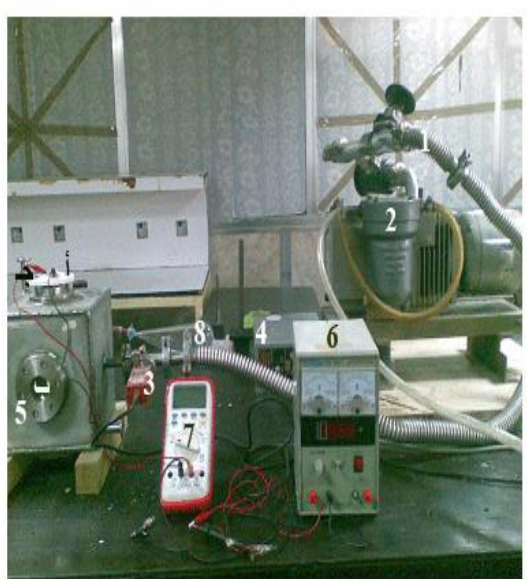
Fig. 6: Gases sensor system .